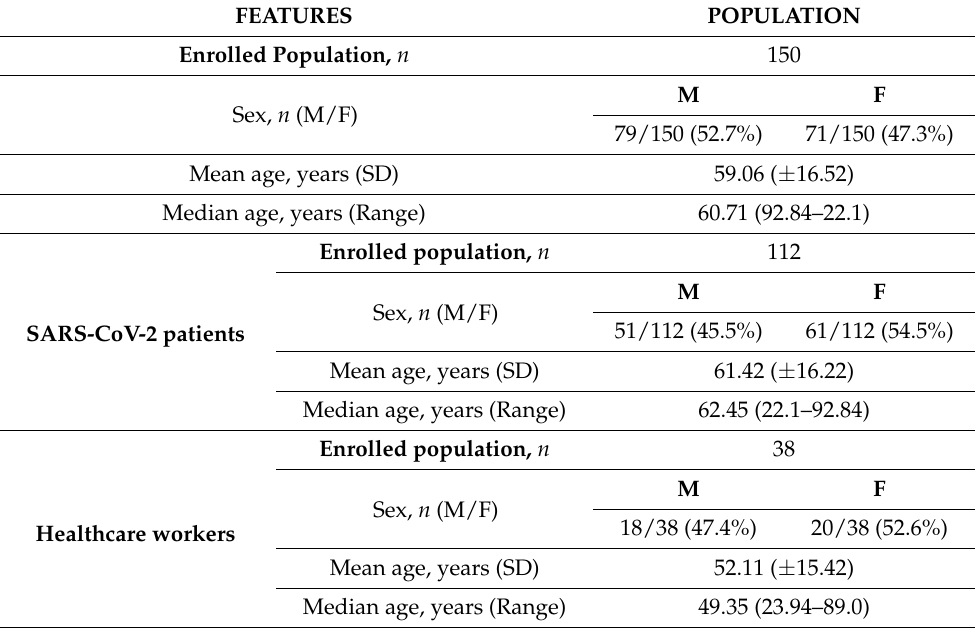
Table 1. Demographic